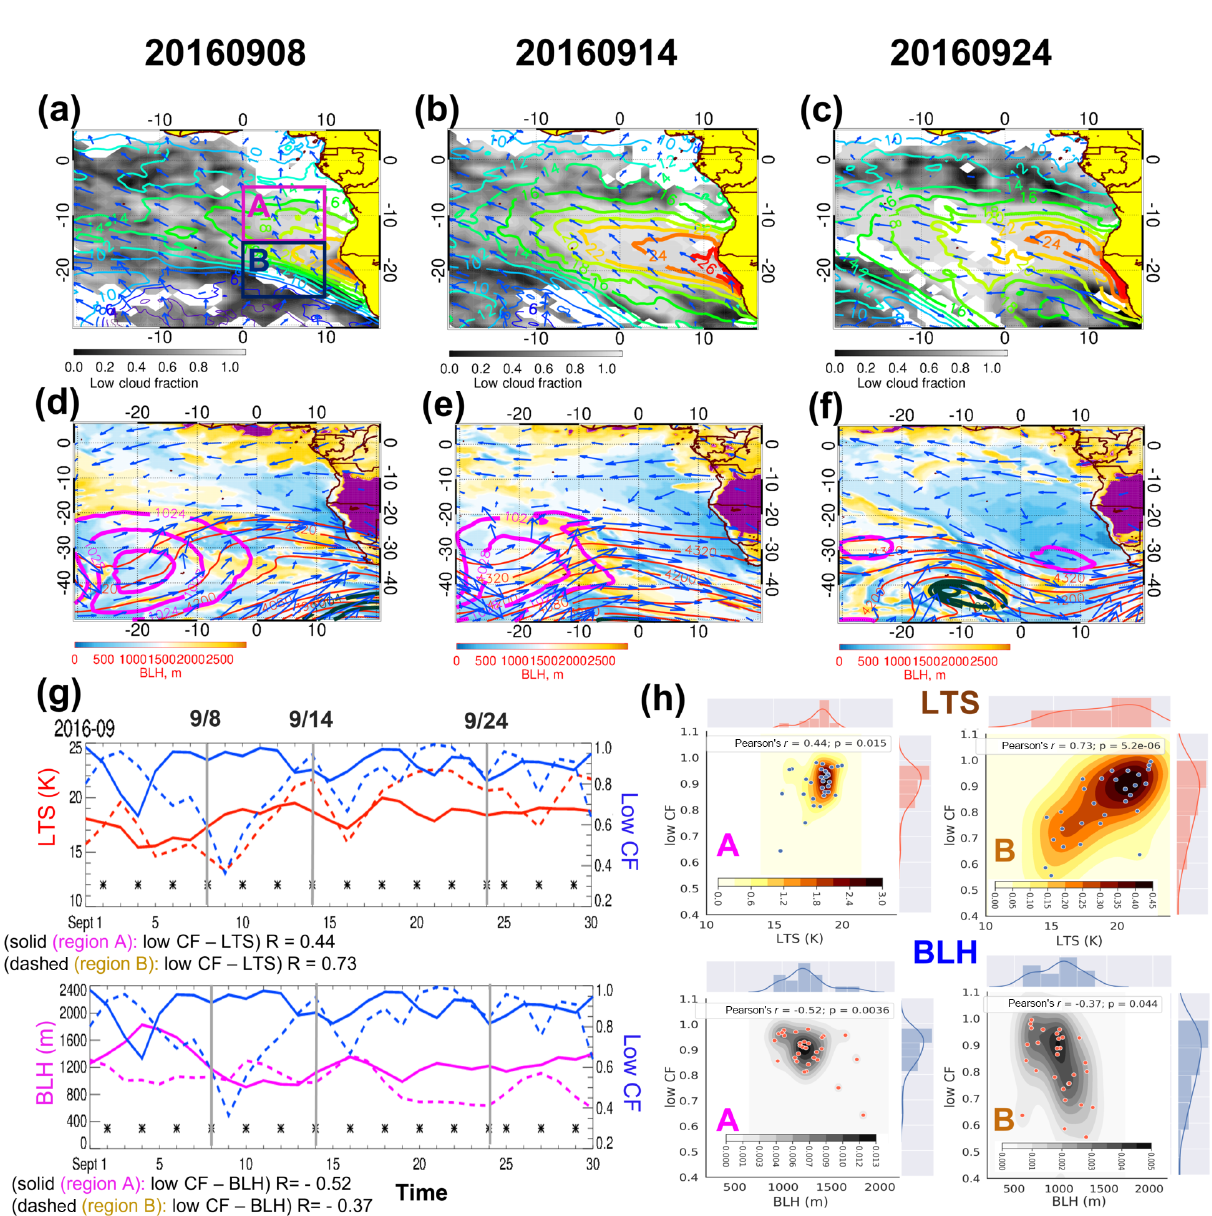
Figure 6. Map of the (a–c) daily mean low CF (shading) overlaid by LTS (contour; K) and 925hPa horizontal winds (vectors; ms − 1 ), (d–f) BLH (shading; m) overlaid by 600hPa horizontal winds (vectors; ms − 1 ), 600hPa geopotential height (red lines; m), and sea level pressure (SLP; lines with dark green, low pressure, at 996, 1000, and 1004 and magenta, high pressure, at 1024, 1028, and 1032; hPa) at 12:00UTC on 8, 14, and 24 September 2016. (g) The top plot shows the time series of the daily mean low CF (blue lines) and daily mean LTS (red lines; K), while the bottom plot shows the daily mean low CF (blue line) and daily mean BLH (magenta lines; m) averaged over region A (0–10 ◦ E, 5–15 ◦ S; solid lines) and region B (0–10 ◦ E, 15–25 ◦ S; dashed lines) during September 2016. All flight days (8, 14, and 24 September 2016) are marked by an asterisk (gray vertical lines). The purple shading over the land in panels (d) – (f) refers to BLH higher than 3250m. (h) The 2-D joint probability density function (pdf; shading) with a scatterplot is shown with 1-D histogram (pdf in line) of the (top) daily mean low CF and LTS and (bottom) daily mean low CF and BLH over region A (left) and B (right) during September 2016. The solid line in panel (a) indicates region A (magenta box) and region B (navy box), respectively. The Pearson’s r in panel (h) refers to Pearson correlation coefficient with its statistical significance ( p